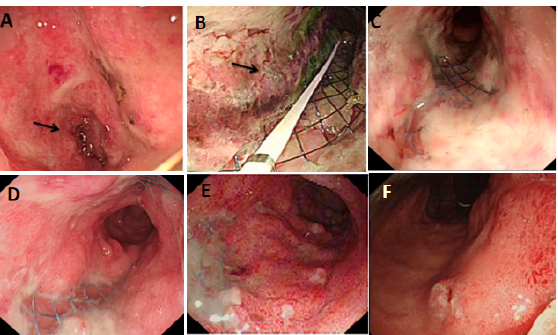
Figure 3. A patient with AGC with pyloric obstruction received PDT. ( A ) Gastroscope shows tumor invasion from the lesser curvature to the pylorus, and the arrow indicates the pyloric stenosis; ( B ) PDT, the arrow points to the visible optical fiber inserted into the original stenosis (metal stent area), and the mucosa is white and necrotic after irradiation; ( C ) after one week of PDT, the local mucosa was gray and white, showing ischemic changes; ( D ) after one month of PDT, the lumen at the pylorus was unobstructed; ( E ) the tumor tissue from the anterior wall of the lesser curvature to the pylorus was smaller than before; ( F ) the lumen was still unobstructed after five months of